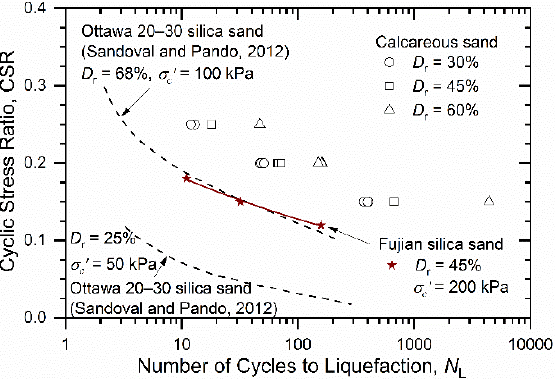
Figure 12. Comparison between the calcareous sand and Fujian and Ottawa 20–30 silica sand.